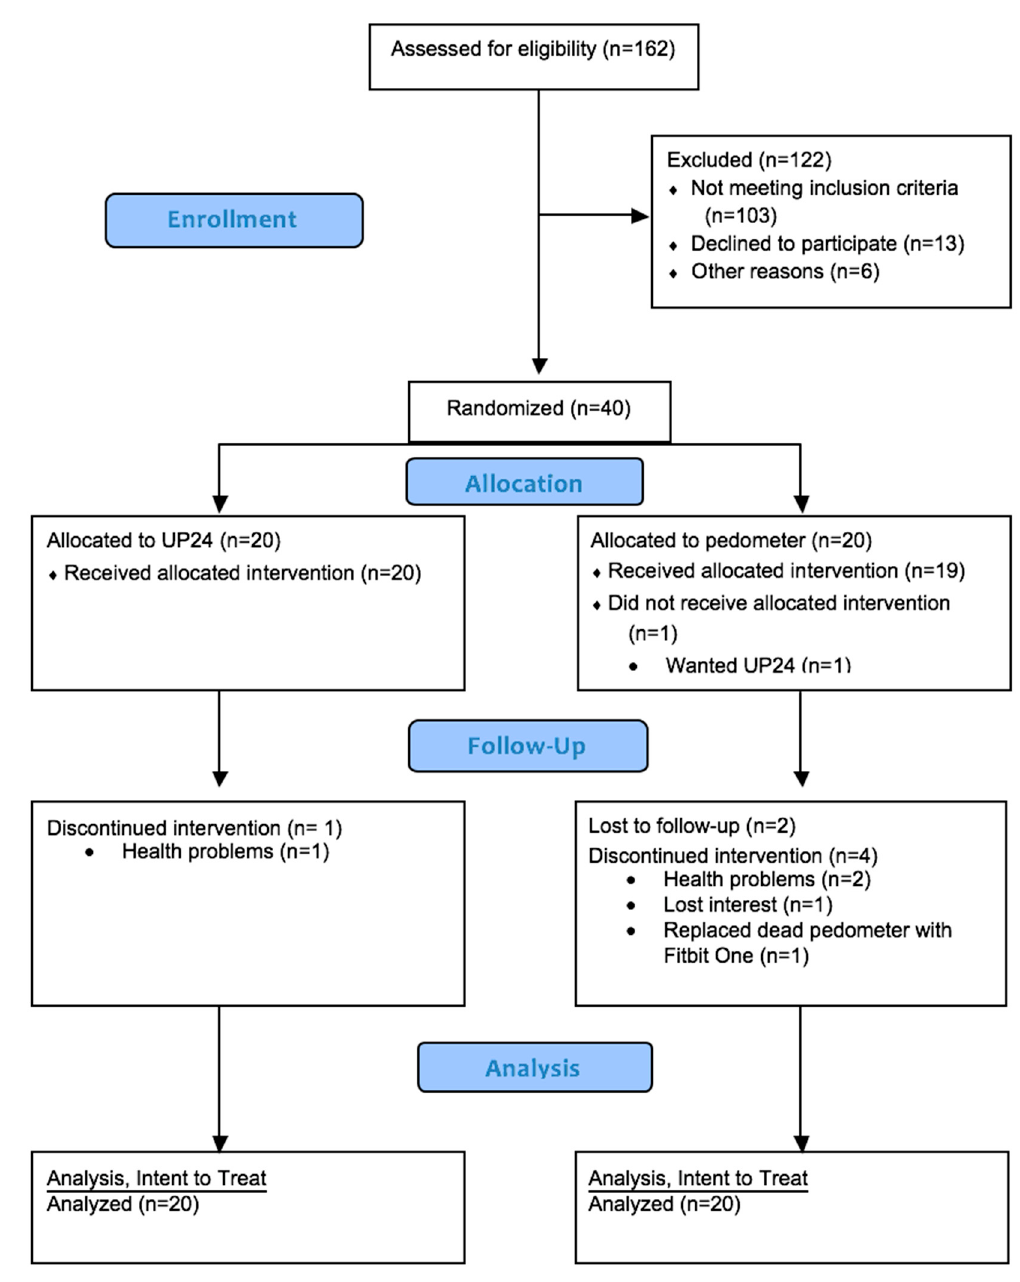
Figure 1. Consort flow diagram.